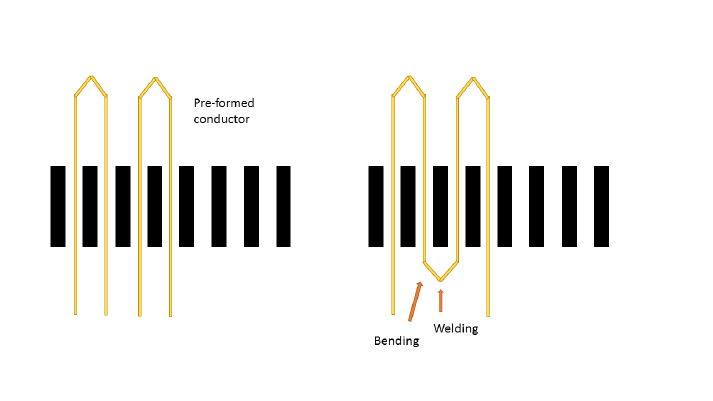
Figure 2. Manufacturing process of hairpin